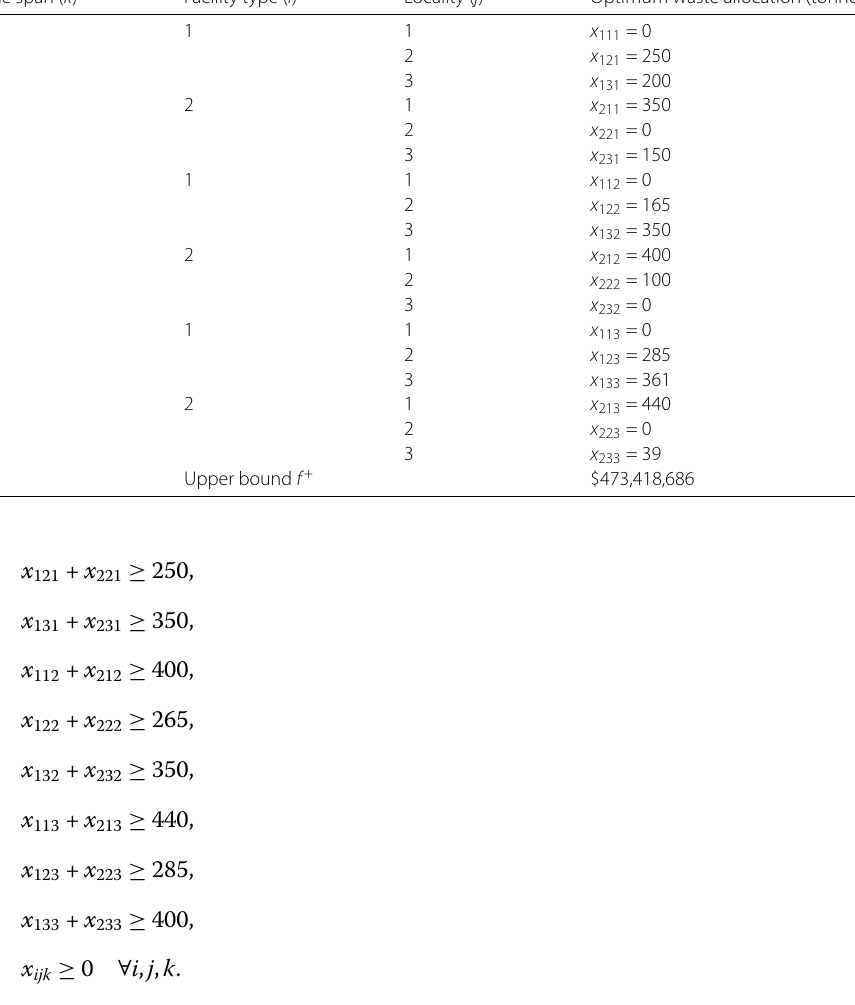
Table 7 Optimal values of variables for upper bound f + Time span ( k